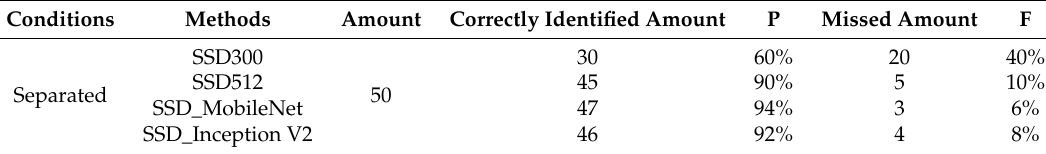
Table 3. The detection results of different methods under main stem occlusion